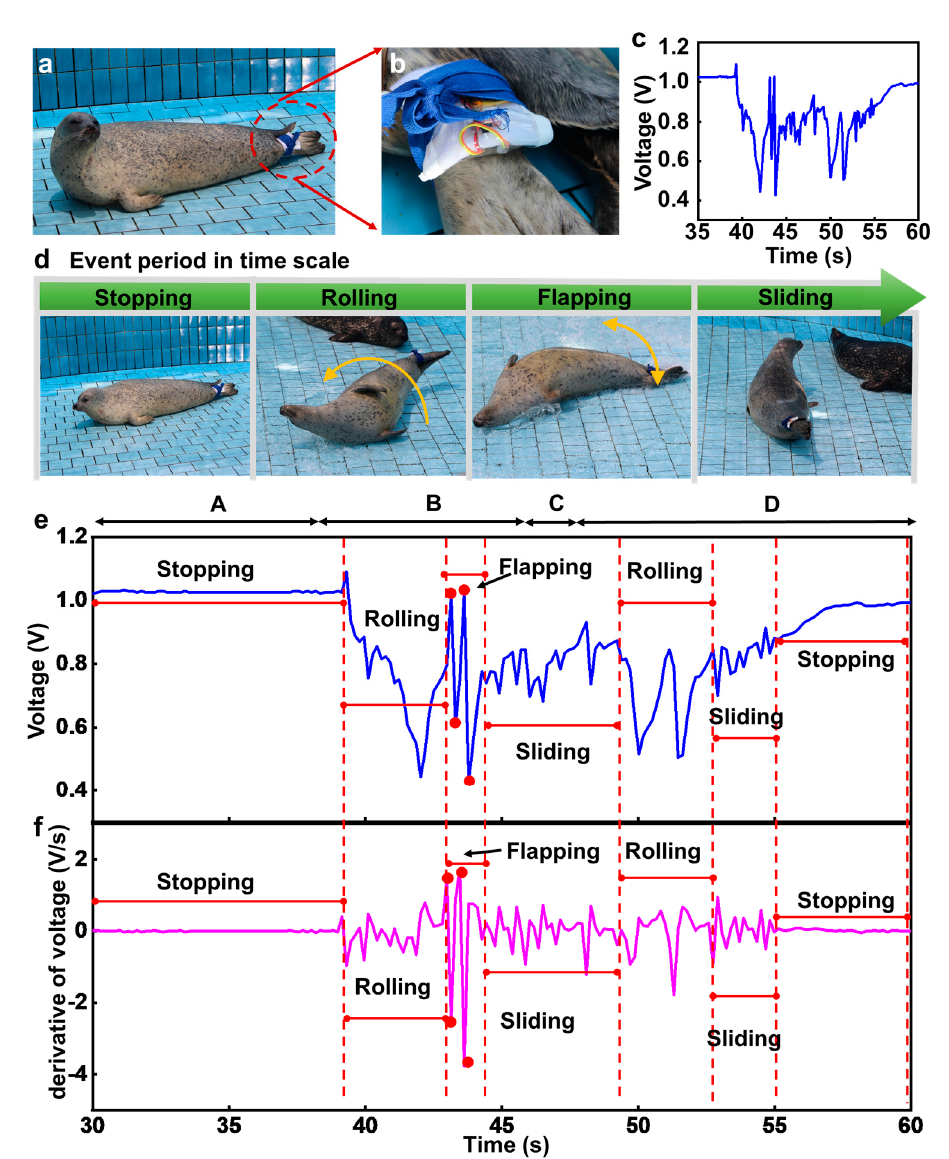
Figure 5. Field test process for motion capture of captive harbor seal (HS) and data analysis. ( a ) Optical image of the captive HS with biologging on the flippers. ( b ) Magnified image of the biologging system. ( c ) Voltage output plots for pressure sensors as a function of time during remote recognition of behaviors for the captive HS. ( d ) Images of the captive HS during representative motions: stopping, rolling, flapping, and sliding. ( e ) Voltage output and ( f ) its derivative as a function of time (i.e., dV/dt), corresponding to the event period.